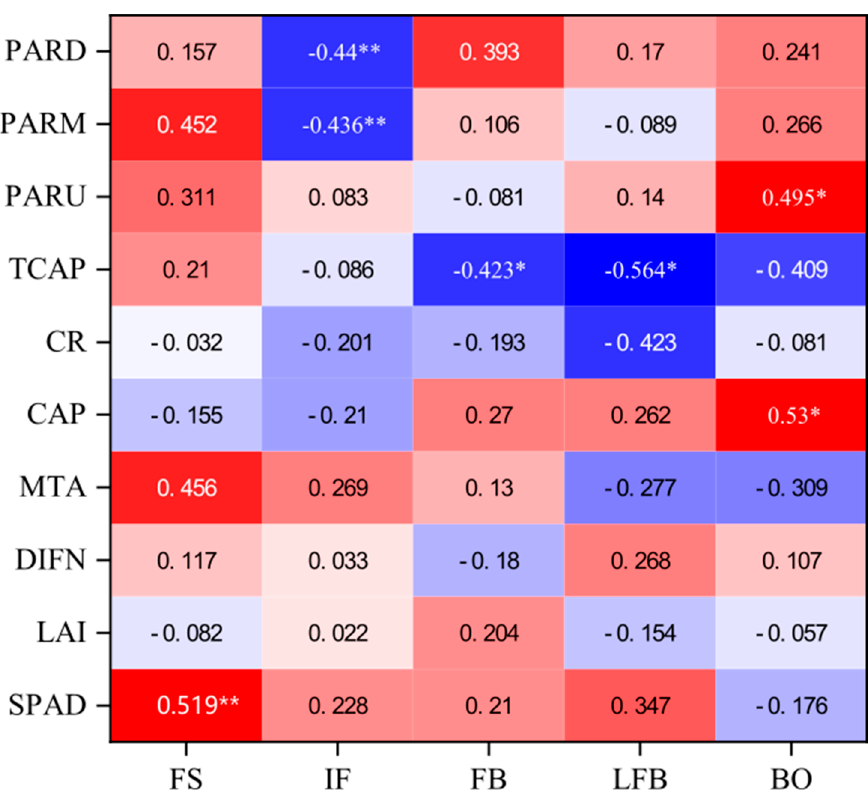
Figure 8. Effect of organic liquid fertilizer combined with different ratios of chemical fertilizers on cotton yield and quality. Different letters above the columns indicate statistical significance at the p = 0.05 level between different treatments in each year.